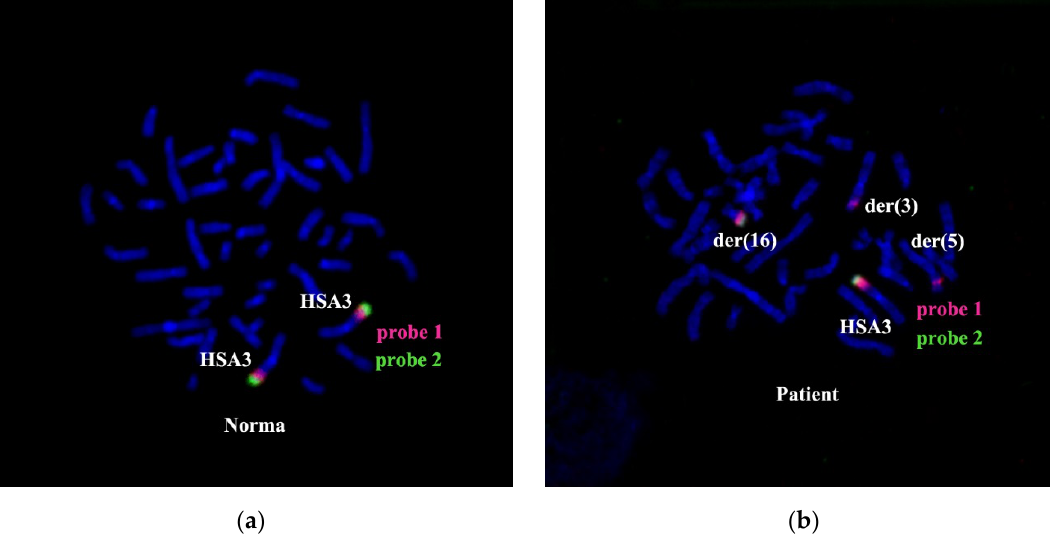
Figure 8. CISS hybridization with PCP3q25 → q26 (probe1) and PCP3q25 → qter (probe 2) on chromosomes of a healthy individual ( a ) and the patient ( b ). Chromosomes with signals are indicated: HSA3—intact chromosome 3, der(3), der(5), and der(16)—derivatives of chromosomes 3, 5, and 16, respectively.